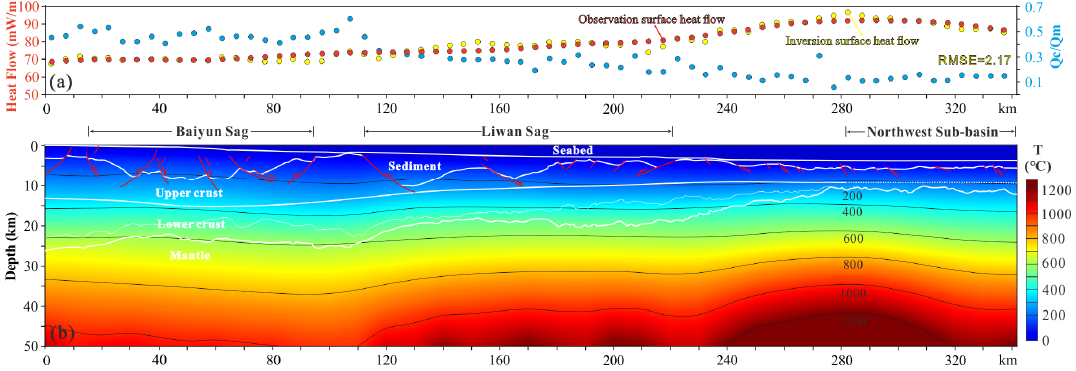
Figure 6. ( a ) The heat flow from observation and inversion along profile L3 are represented by red and blue points, respectively. The ratio between crustal heat flow and mantle heat flow is indicated by yellow points. Q c , crustal heat flow; Q m , mantle heat flow. ( b ) Thermal structure calculated from the simulation of profile L3.